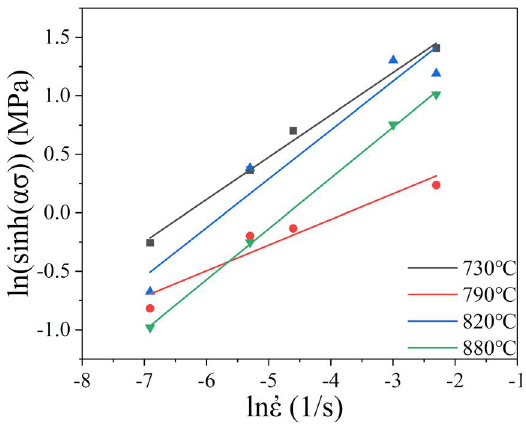
8 of 15 Table 5. Third-order polynomial fitting results of parameters, with strain, for the β phase region. b